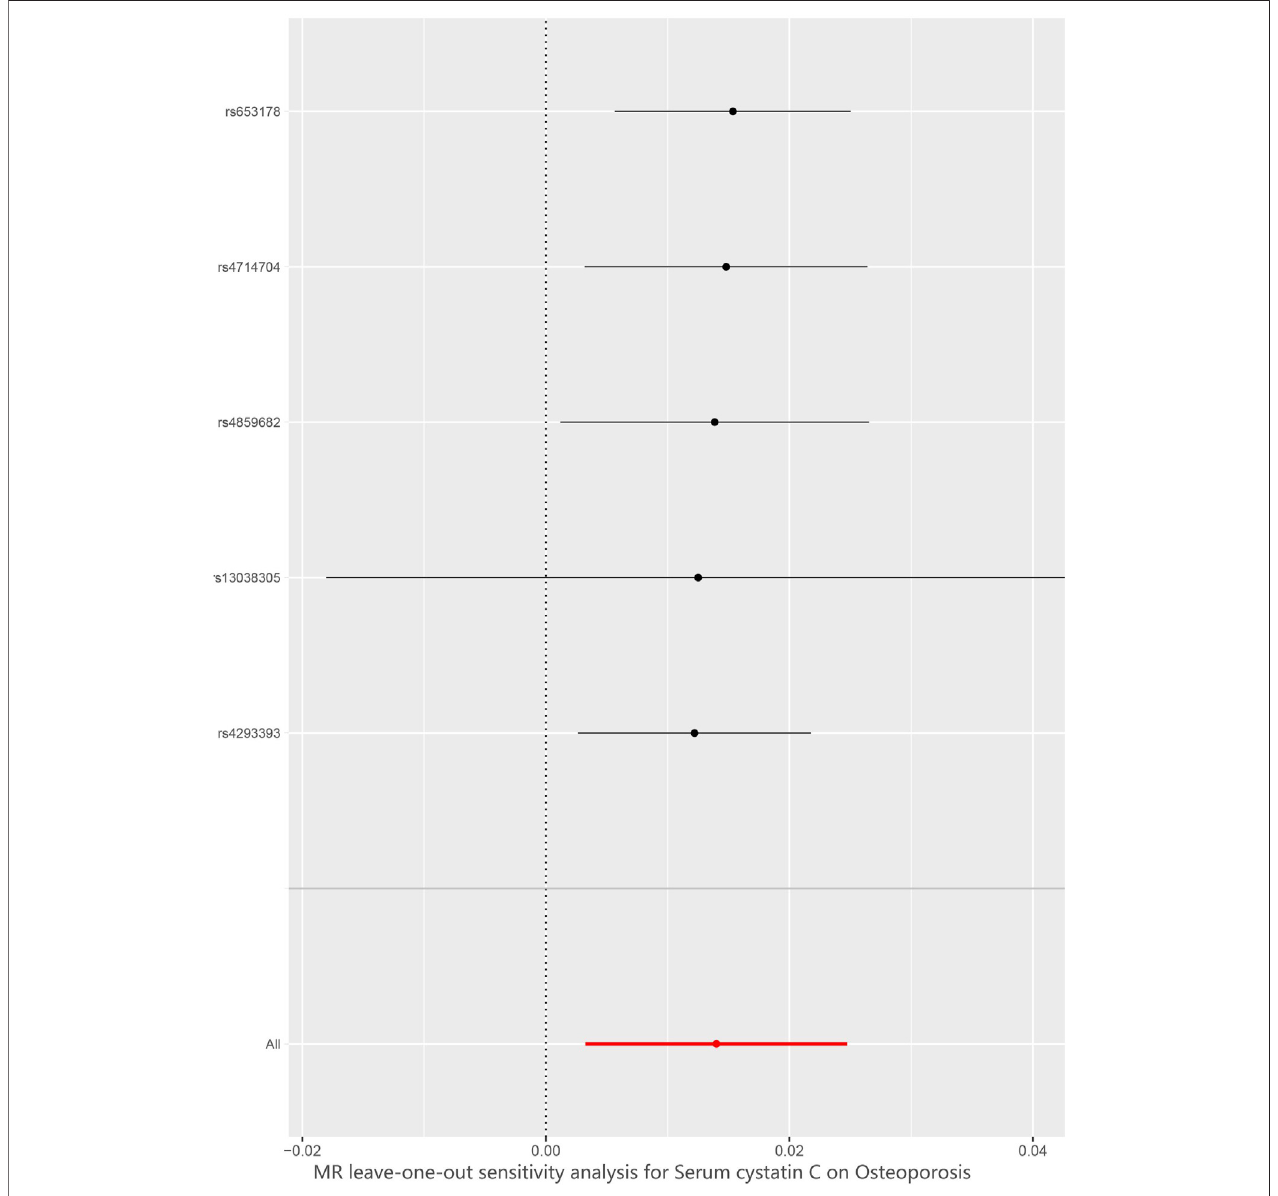
FIGURE6| Leave-one-outplottovisualizecausaleffectofCystatinContotalosteoporosisriskwhenleavingoneSNPout.MRindicatesMendelianrandomization.